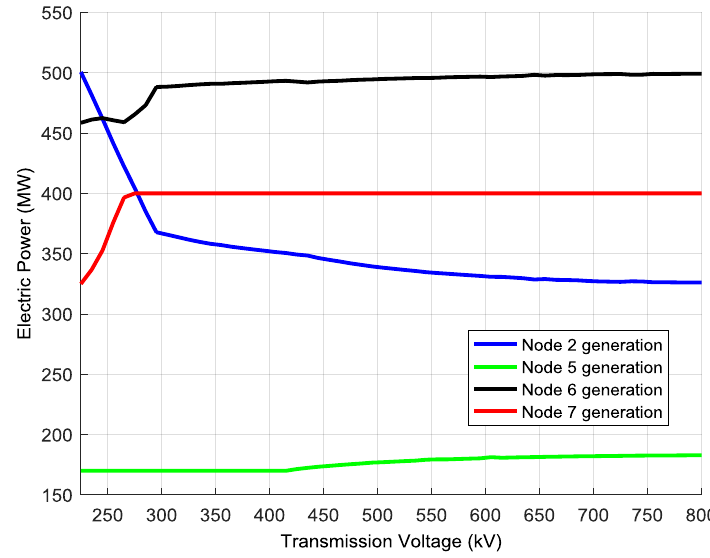
Figure 6 . Power plant dispatch as a function of the voltage increasing. Figure 6. Power plant dispatch as a function of the voltage increasing.